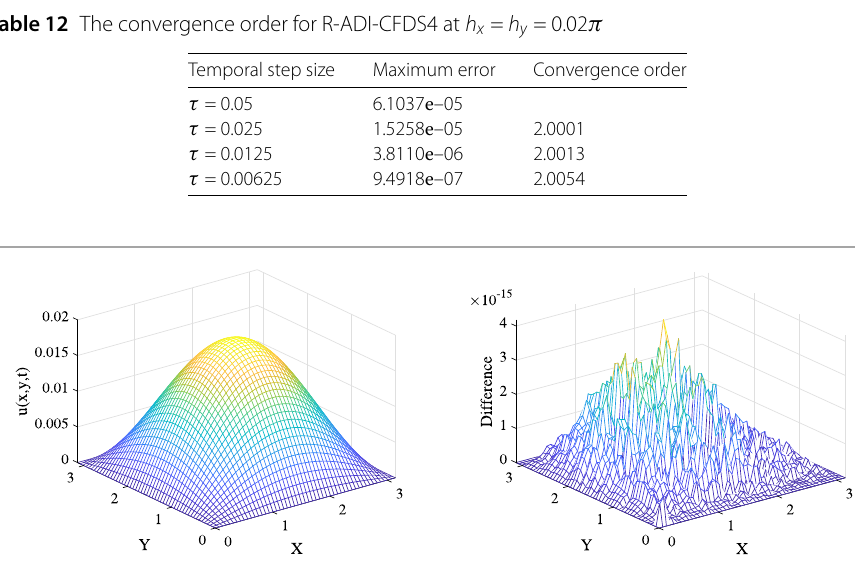
Figure 9 The figures of solutions of R-ADI-CFDS4(left) and difference(right) between R-ADI-CFDS4 and ADI-CFDS4 at t = 2, with h x = h y = 0.02 π and τ = 0.02 for SP 3